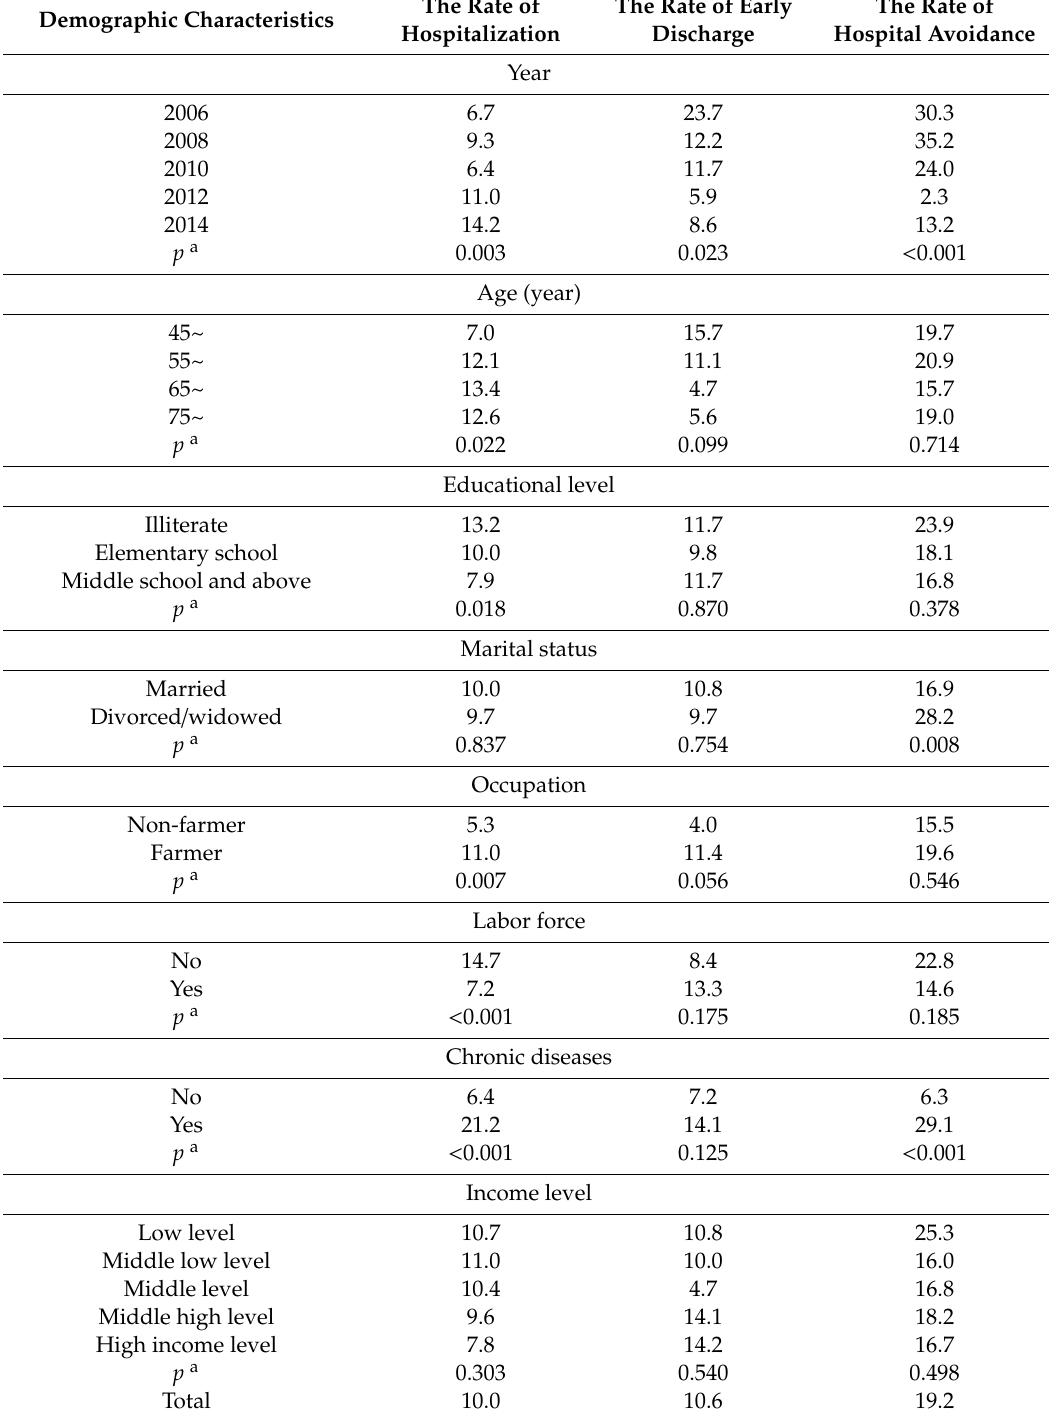
Table 3. Comparison of the di ff erence of three indexes of inpatient service utilization after data weighted between di ff erent characteristic MAEF